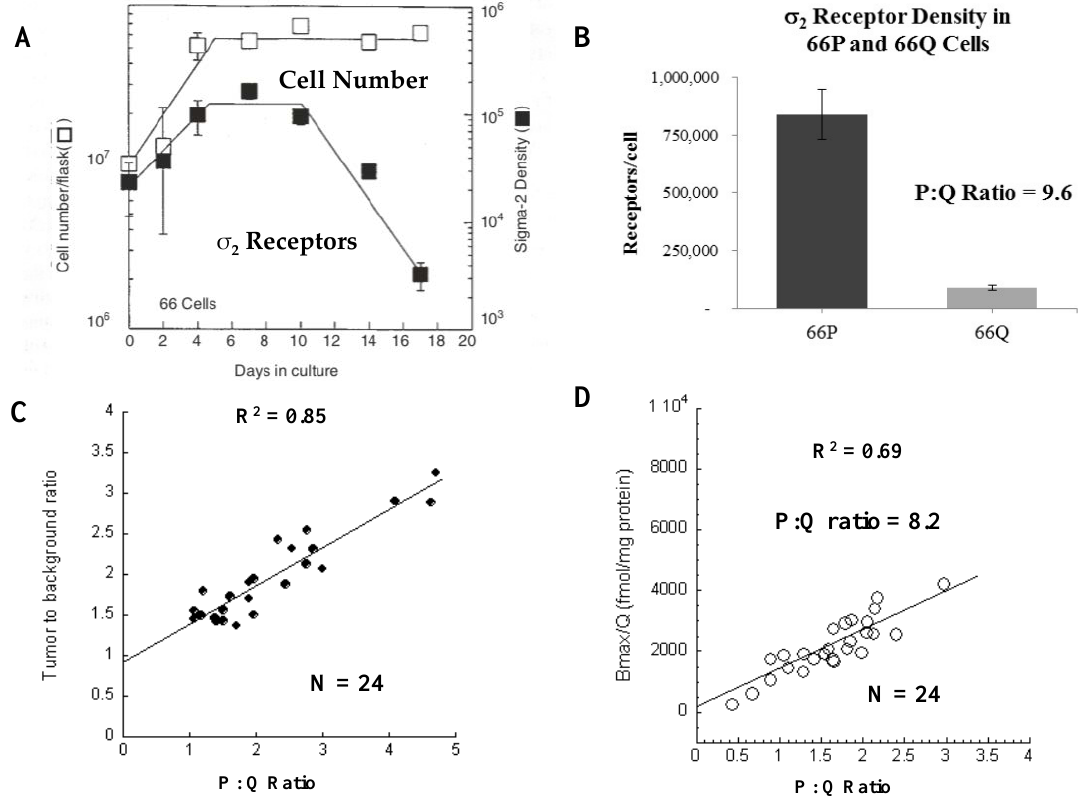
Figure 2. Relationship of the s2R with cell proliferation. ( A ) Comparison of the growth curve of 66 cells and the density of s2R in proliferating and quiescent cells. ( B ) Density of s2R in 66P versus 66Q cells. ( C , D ) Comparison of the tumor: Background ratio of [ 18 F]ISO-1 uptake ( C ) and s2R density ( D ) versus the P:Q ratio of solid 66 tumors. Adapted from [16,17].